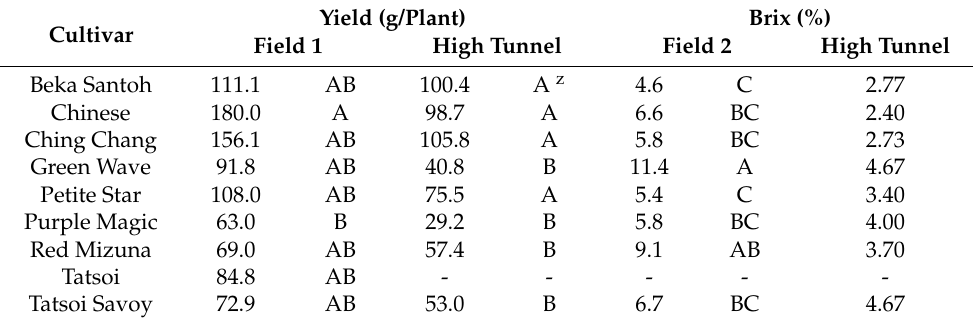
Table 5. Yield and Brix of nine cool-season leaf vegetables grown in the open field and a high tunnel in East Texas. The yield of the second field planting is not presented because all the plants in B. rapa were bolted and flowered. However, leaf Brix was measured in plants grown both in the high tunnel and the open field (second